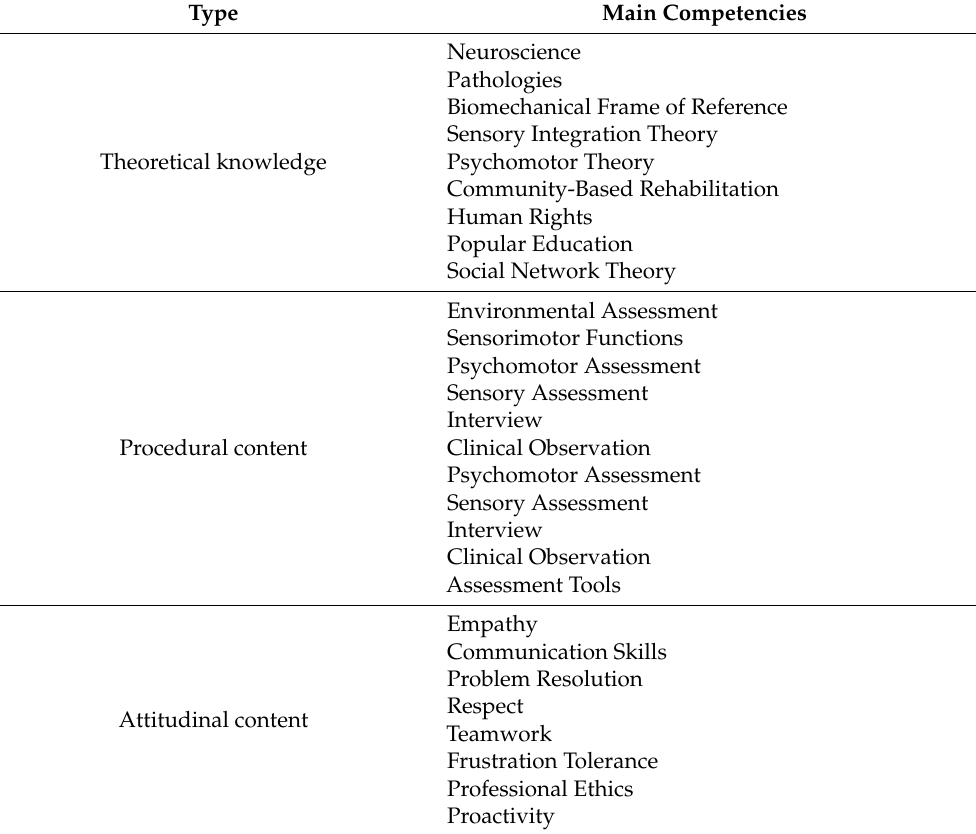
Table 3. Summary of the competencies of a community neurorehabilitation occupational